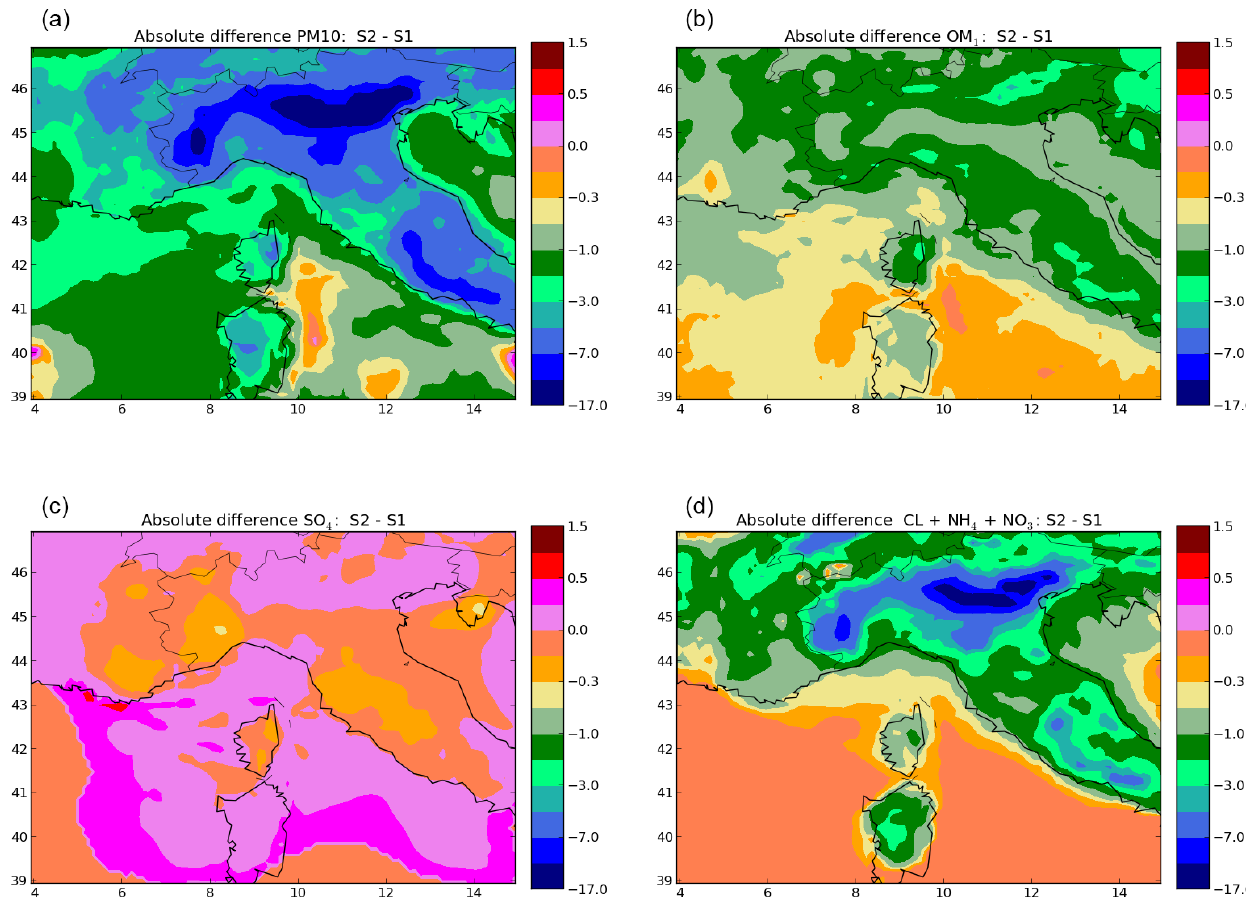
Figure D6. Maps of the absolute differences of the concentrations of PM 10 (a) , OM 1 (b) , sulfate (c) and other inorganics (nitrate, ammonium and chloride) (d) in % between S1 and S2 (b, d) during the summer 2013.